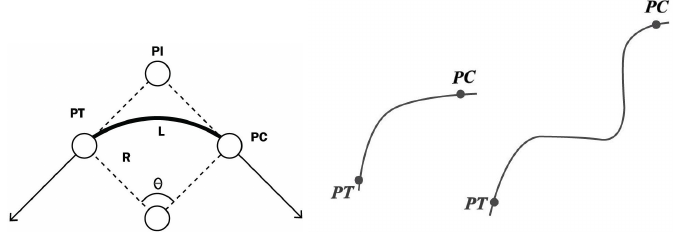
Figure 3. Representation of the parameters and classification of the curve.